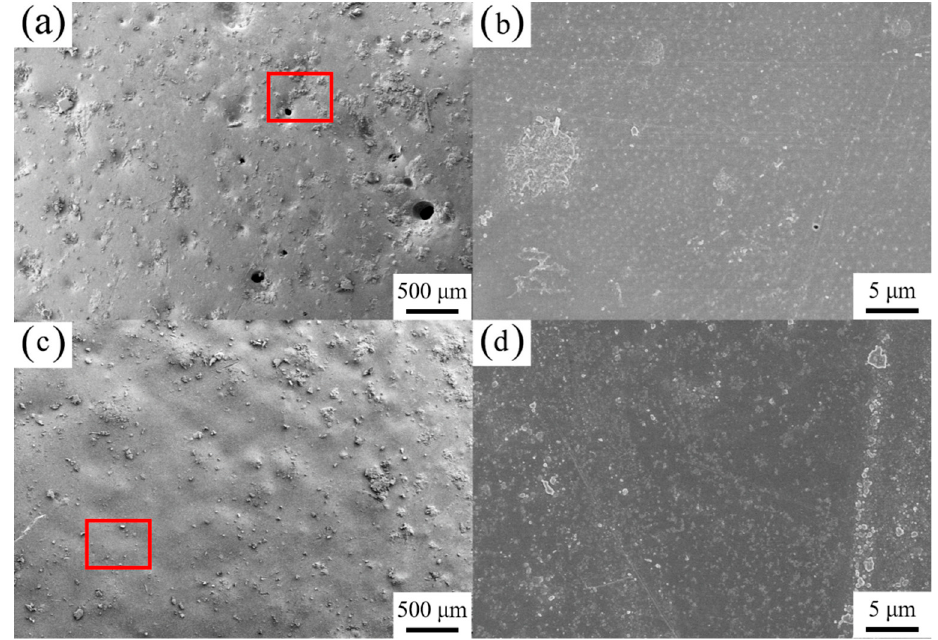
Figure 1. The SEM images for the coated samples ( a , b ) ZRPs and ( c , d ) Gr0.6-ZRPs after immersion in a 3 wt. % NaCl solution for 25 days, where photos with two magnifications are provided (the areas marked by the red box are measured by EDS mapping in Figure 2).